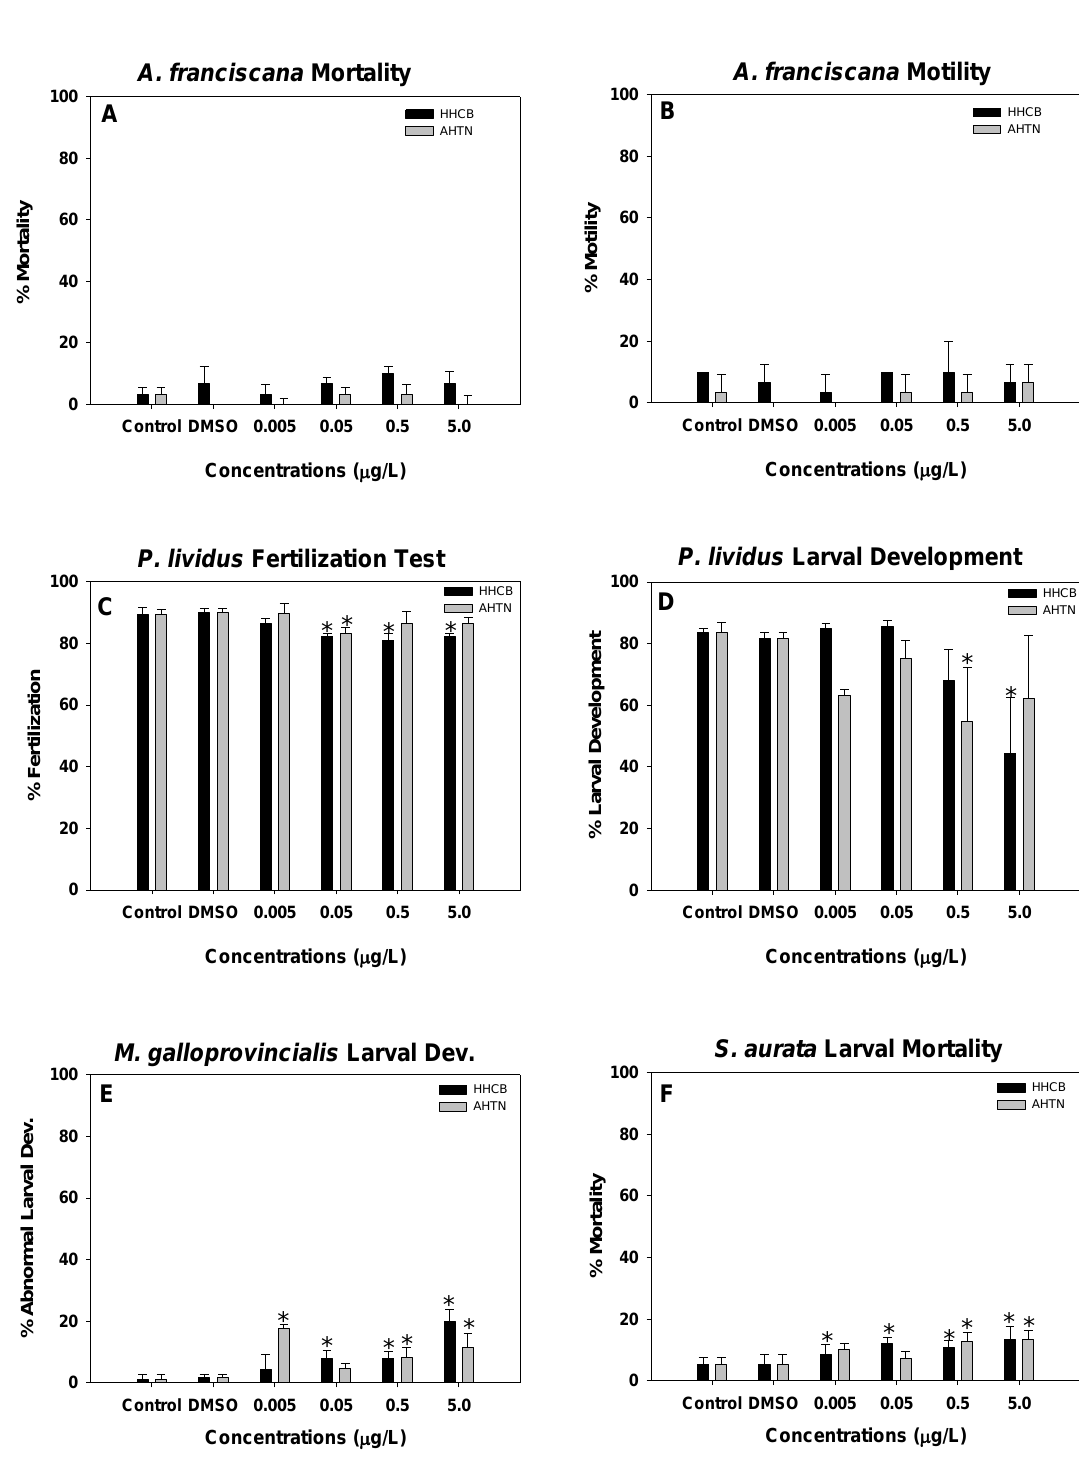
Figure 2. A. franciscana 72 h mortality and motility, P. lividus fertilization and 48 h larval development, M. galloprovincialis 48 h larval development and S. aurata 96 h larval mortality tests exposed to galaxolide and tonalide. Asterisks (*) indicate significant differences (p < 0.05) in relation to control.